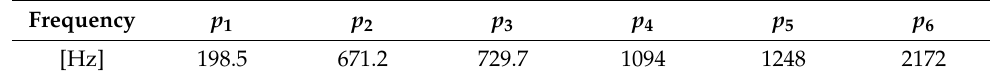
Table 3. The eigenpulsations of the system.